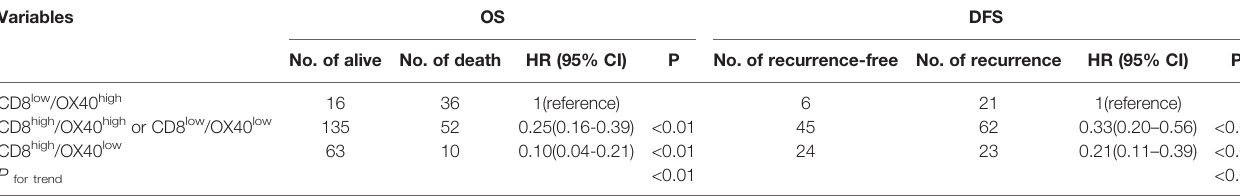
TABLE 2 | Univariate analysis of the ratio of CD8 and OX40 expressions for OS and DFS.